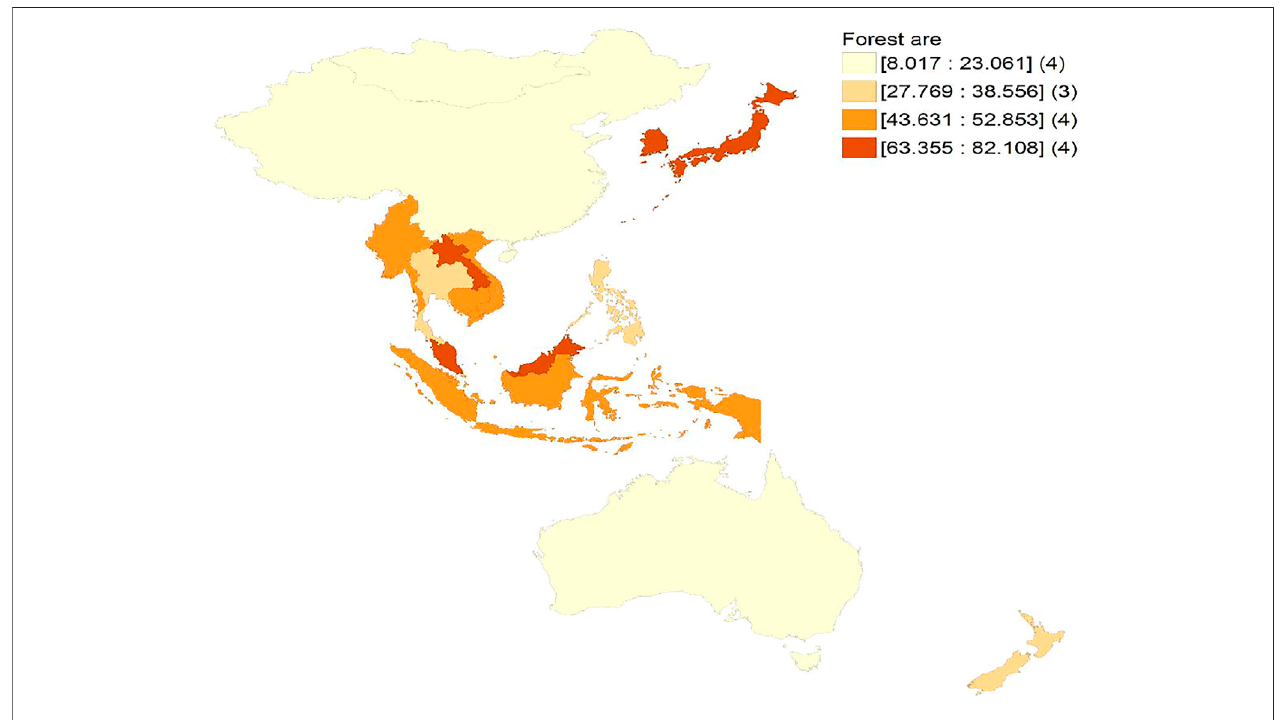
FIGURE 1 | Forest region (as a percentage of land) in the countries.